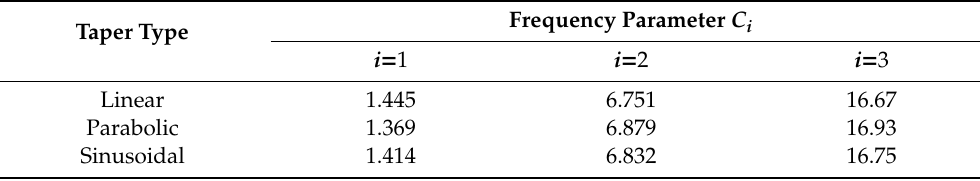
Table 5. E ff ect of taper type on frequency parameter C i